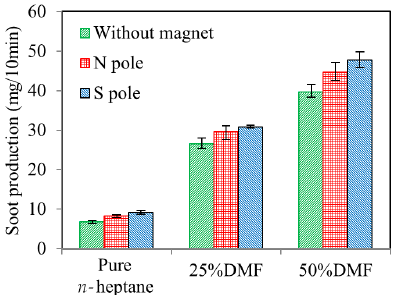
Figure 3. The comparisons of soot production. (Pure n -heptane represents soot collected from pure n -heptane IDF, 25% DMF represents soot collected from n -heptane IDF with 25% DMF-doped, 50% DMF represents soot collected from n -heptane IDF with 50% DMF-doped. The error bars represented the error of the average weight of soot sampled in each 10 min.).